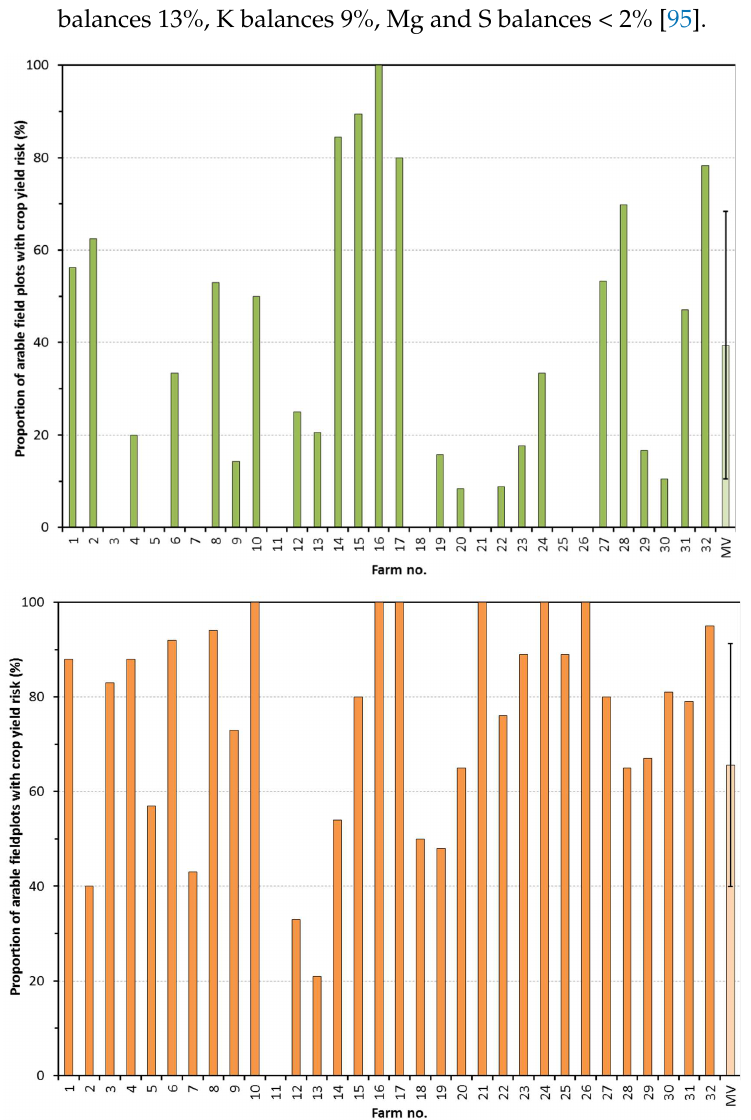
Figure 3. Proportion of yield-limiting field plots per farm due to insufficient intervals of cultivation for potatoes, oilseed crops, grain legumes and/or red clover, alfalfa, and lupine ( top ) as well as in the sum of test characteristics for nutrient management ( bottom ) and the mean values of the farms (MV, including standard deviation).